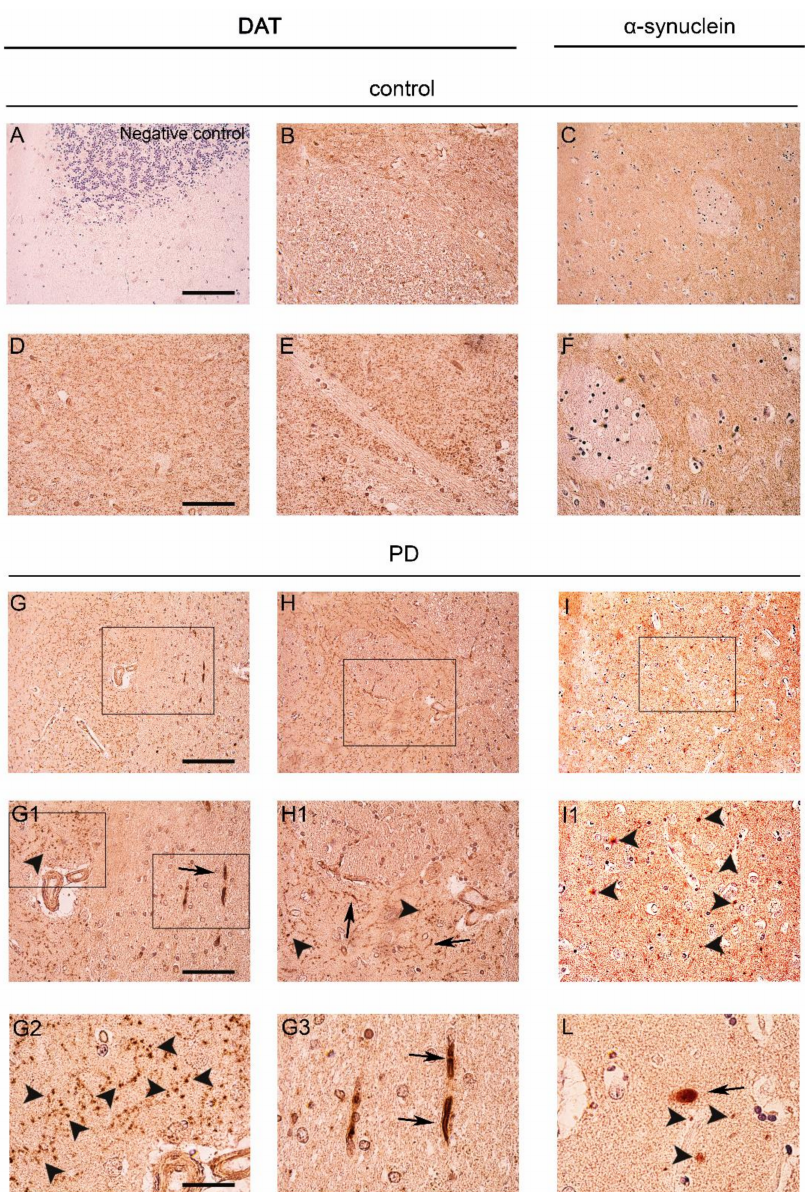
Figure 1. Dopamine transporter (DAT) staining in the caudate putamen of PD patients and age-matched controls. ( A ) Representative photomicrograph showing the negative control produced by performing DAT immunolabeling on cerebellum sections. Please note the absence of staining that is indicative of the specificity of the DAT antibody used for this study; ( B , D , E , G , H , G1 , H1 , G2 , G3 ) Representative images showing DAT immunolabeling in the caudate putamen of PD patients and age-matched controls subjects. DAT immunolabeling showed a small dot-like appearance with widespread distribution in the control sections ( B , D , E ). Please note that in spite of the overall decrease of immunolabeling, in the PD brains, the DAT signal was accumulated in big neuropil-like dots ( G , H , G1 , H1 , G2 , arrowheads) and in few neuritic-like structures ( G , G1 , G3 , arrows); ( C , F , I , I1 , L ) Panels are showing α -synuclein immunolabeling in the caudate putamen of PD patients and age-matched control subjects. Alpha-synuclein immunolabeling showed a widespread distribution in the grey matter in control sections ( C , F ). Please note the presence of neuropil-like α -synuclein-positive dots ( I , I1 , L , arrowheads) and LB-like structures in the PD brains ( L , arrow). Scale bars: ( A – C , G – I ) 100 µ m, ( D – F , G1 , H1 , I1 ) 50 µ m, ( G2 , G3 , L ) 20 µ